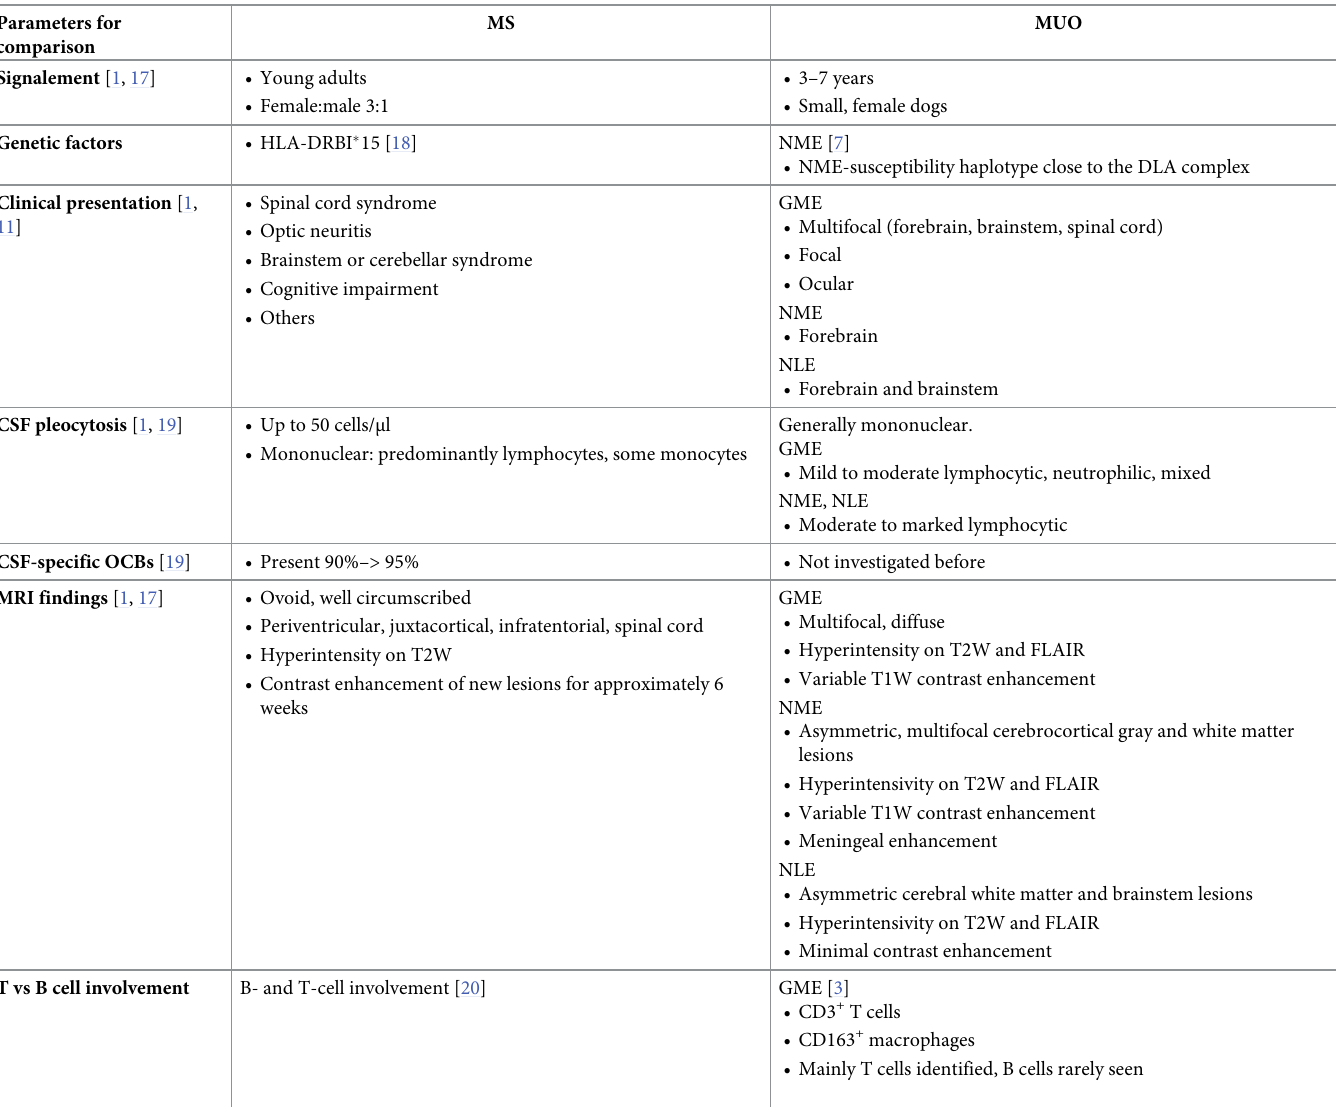
Table 1. Comparison of MS in humans and canine